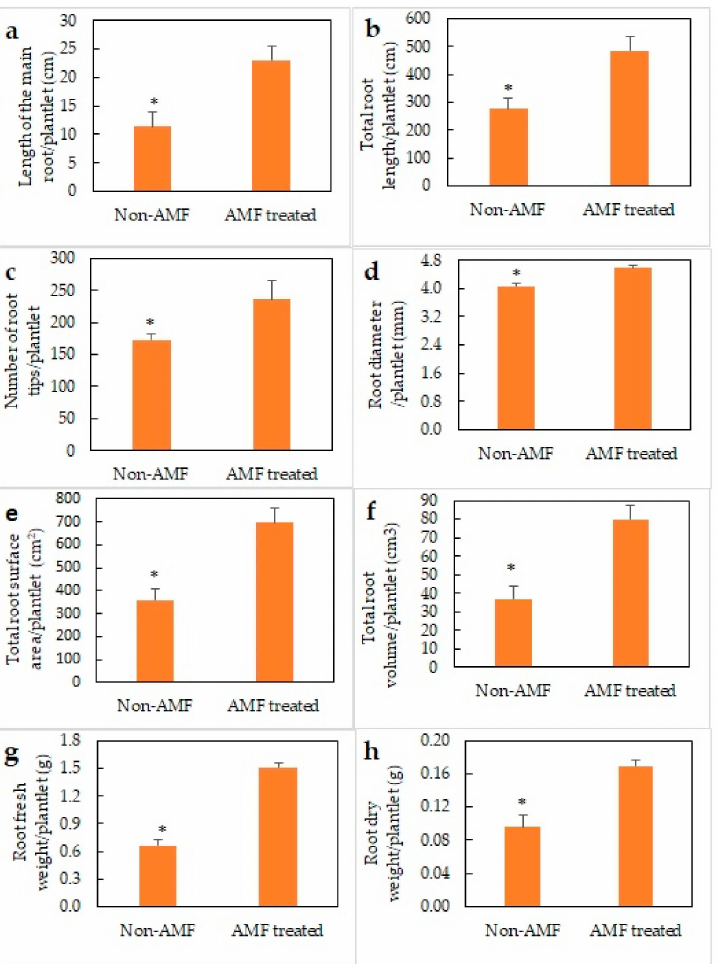
Figure 4. Root growth characteristics in non-AMF and AMF-treated Philodendron bipinnatifidum plants after 8 weeks of acclimatization. ( a ) Length of the main root per plantlet, ( b ) Total root length per plantlet, ( c ) Number of root tips per plantlet, ( d ) Root diameter per plantlet, ( e ) Total root surface area per plantlet, ( f ) Total root volume per plantlet, ( g ) Root fresh weight per plantlet and ( h ) Root dry weight per plantlet. * = Significant at p ≤ 0.05 according to unpaired t